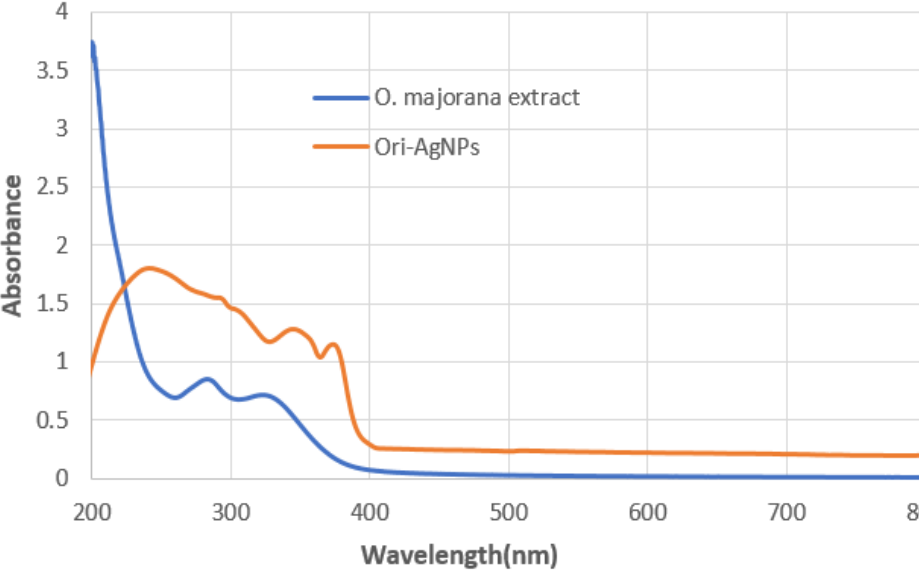
Figure 2. UV-vis spectrum of both O. majorana extract and the biogenic AgNPs .